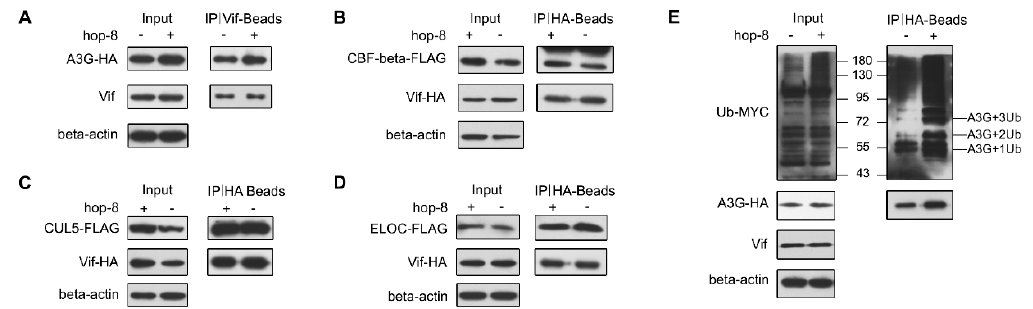
Figure 6. Hop-8 did not interfere in the interaction of Vif with A3G, CBF- β , Elongin C, or Cullin 5. ( A ) Hop-8 did not interfere in Vif and A3G interaction. The plasmid pcDNA3.1-APOBEC3G-HA (3 µ g) was transfected into 2 × 10 6 Trex-hvif-15 cells and treated with 0.1 µ g/mL Dox and 2.7 µ M hop-8 or DMSO for 48 h. Cells were treated with 10 µ M MG-132 for 16 h. Co-IP assays were performed with an anti-HIV1 Vif antibody; ( B – D ) Hop-8 did not block the interaction between Vif and CBF- β ( B ), Elongin C ( C ), or Cullin 5 ( D ). The plasmids pcDNA3.1-Vif-HA (1.5 µ g) and pcDNA3.1-CBF- β -FLAG (1.5 µ g) or pcDNA3.1-Elogin C-FLAG or pcDNA3.1-Cullin 5-FLAG were co-transfected into 2 × 10 6 293T cells. Cells were treated with 2.7 µ M hop-8 or DMSO. Co-IP assays were performed with an anti-HA antibody; ( E ) The influence of hop-8 on A3G ubiquitination. The plasmids pcDNA3.1-APOBEC3G-HA (1.5 µ g) and pUb-MYC (1.5 µ g) were co-transfected into 2 × 10 6 Trex-hvif-15 cells. Cells were treated with 0.1 µ g/mL Dox and 2.7 µ M hop-8 or DMSO. The Co-IP assay was performed with a rabbit anti-HA antibody.